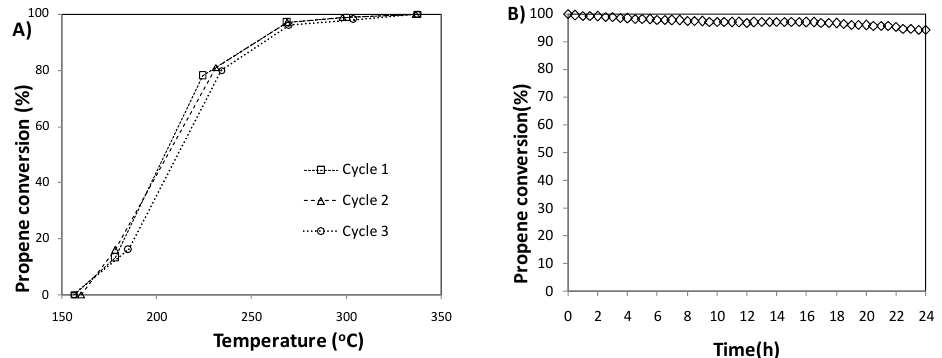
Figure 5. Stability tests for the PdCo-ZnAl catalyst. ( A ) Propane conversion for three successive complete cycles; ( B ) Isothermal stability test at 310 °C for 24 h.